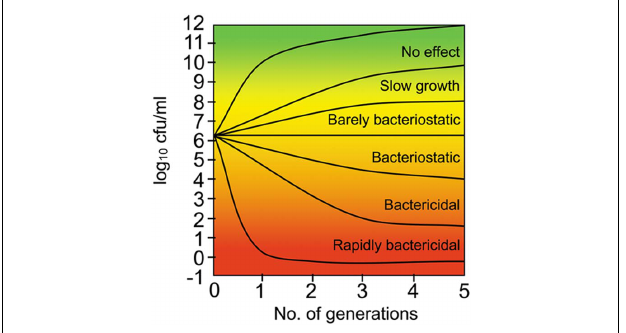
FIGURE 4 |Antisense prediction of bacteriostatic and bactericidal targets. Antisense-induced silencing of essential genes and subsequent monitoring of survival kinetics can be used to delineate targets that will likely produce cidal, static, or no effect upon inhibition of the cognate protein (adapted from Kaur et al.,